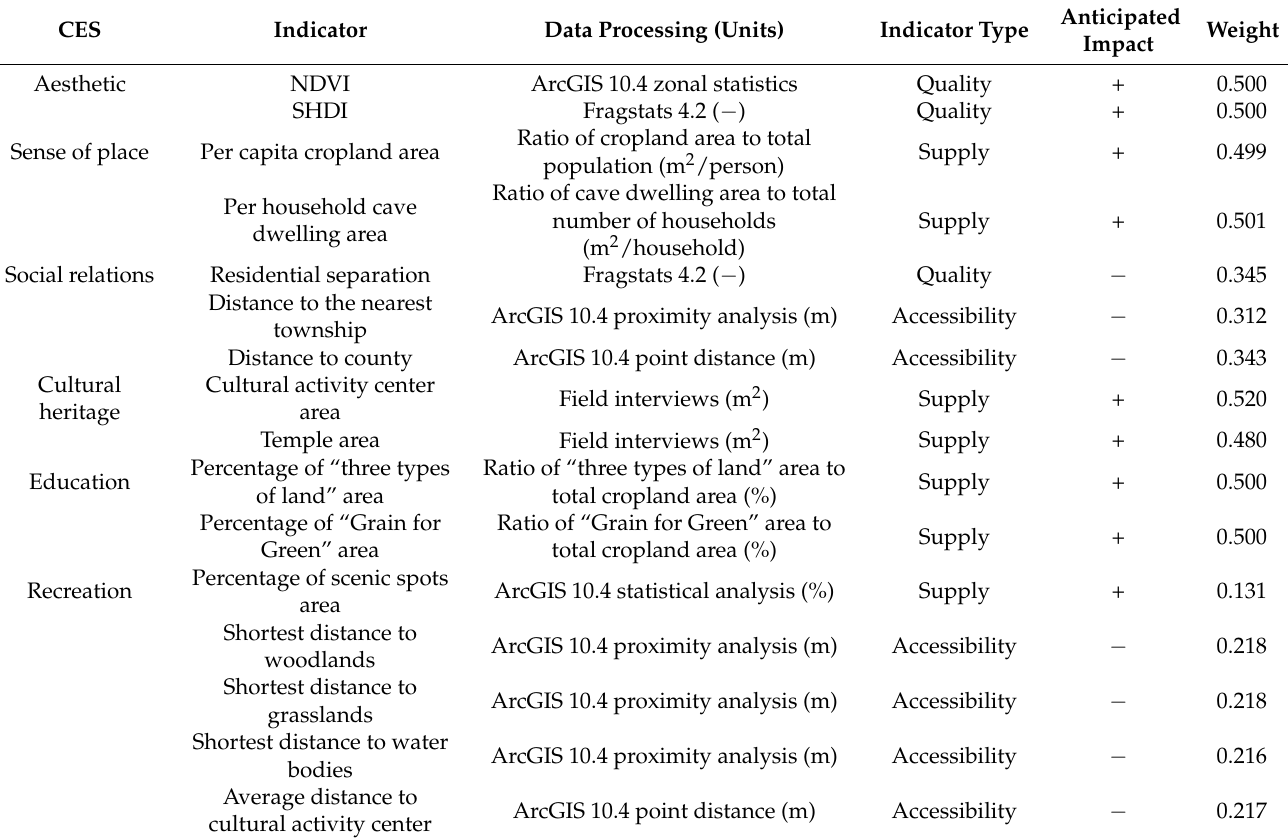
Table 1. Indicator system of cultural ecosystem services in Shigou